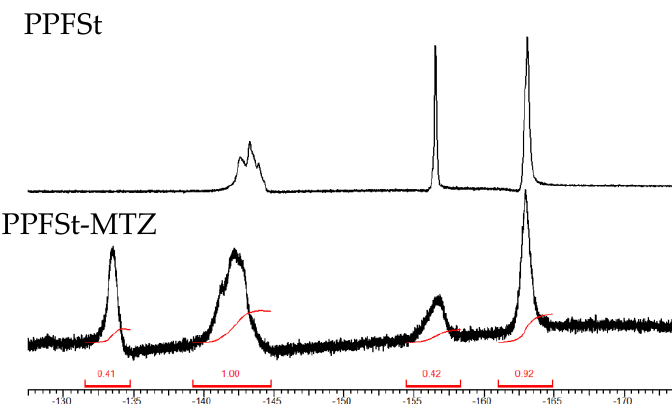
Figure 2. The 19 F-NMR spectra of poly(pentafluorostyrene) (PPFSt) and PPFSt-MTZ.